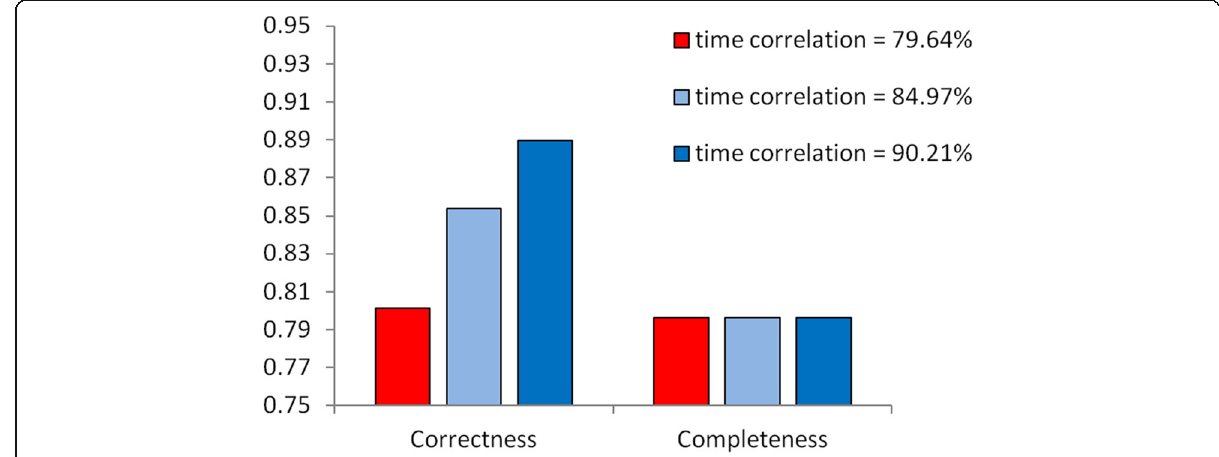
Fig. 6 The effect of time-related indicators on other